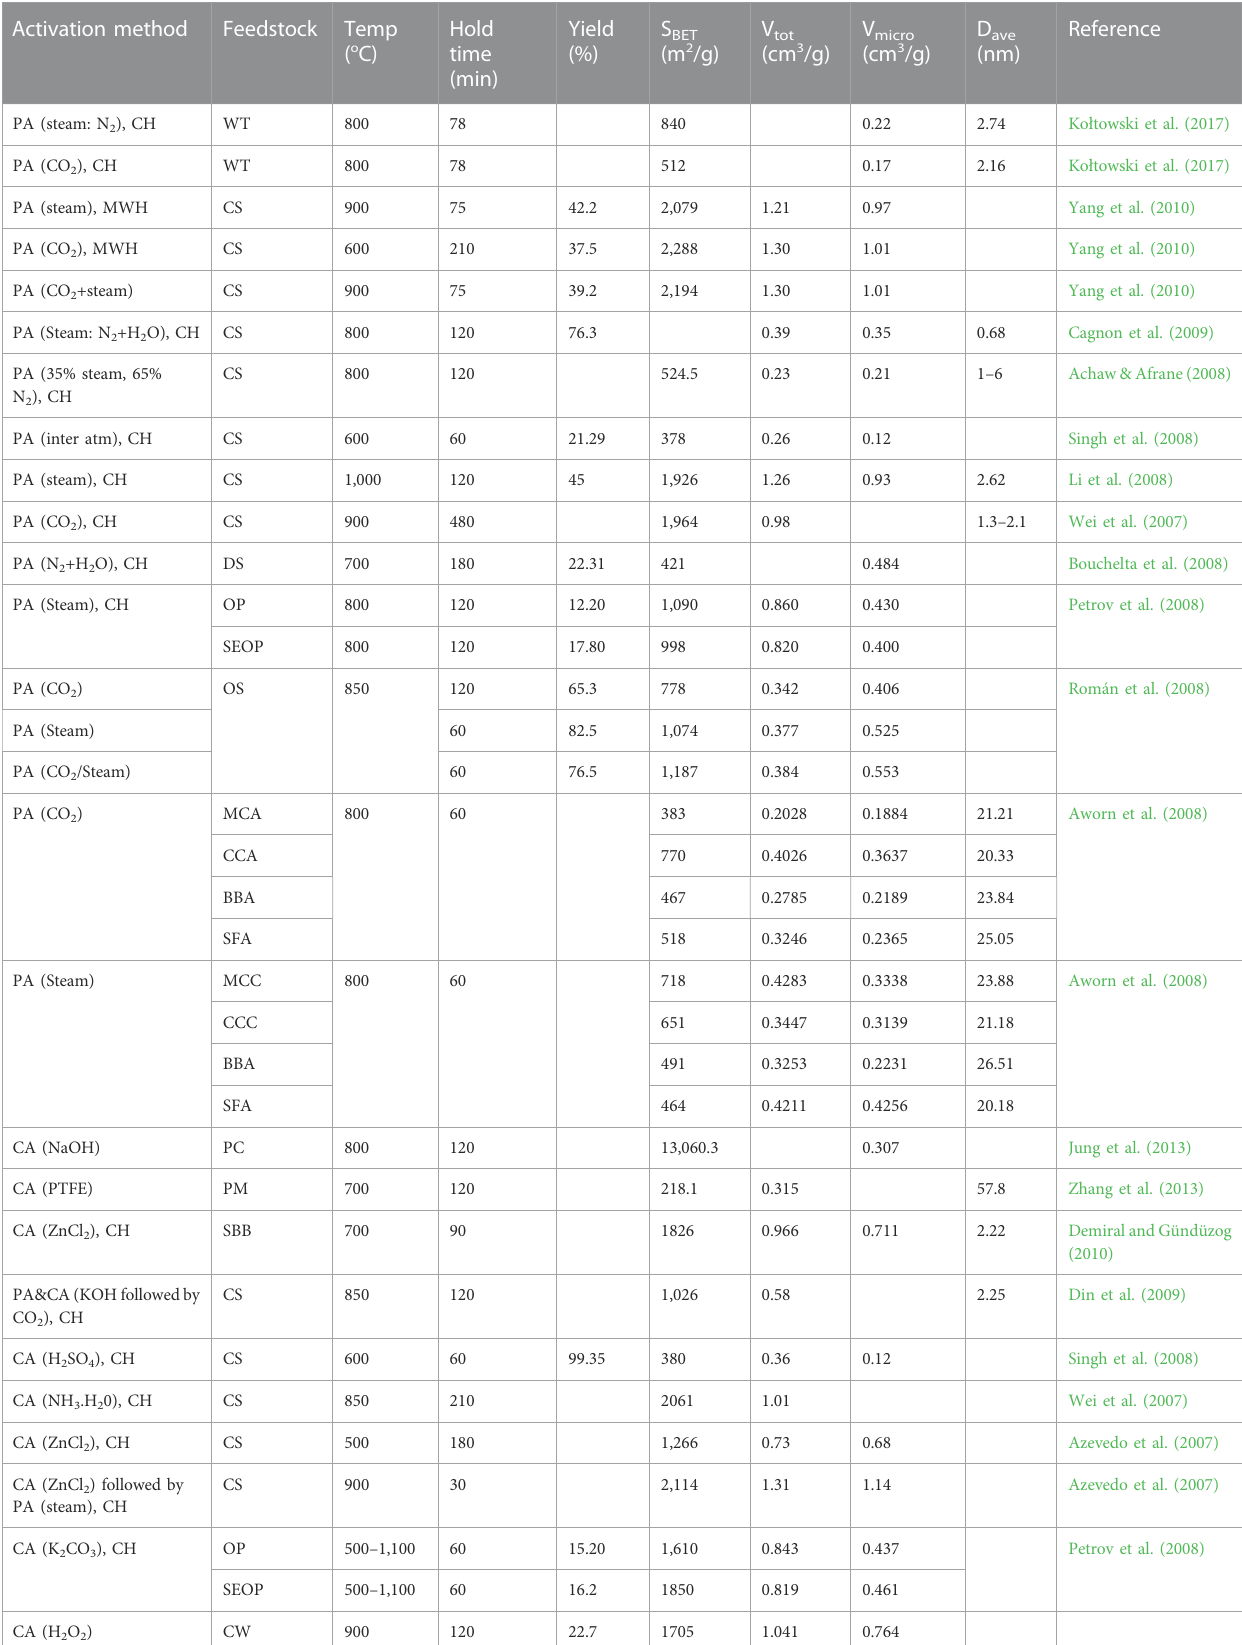
TABLE 5 General characteristics of activated biochar from different